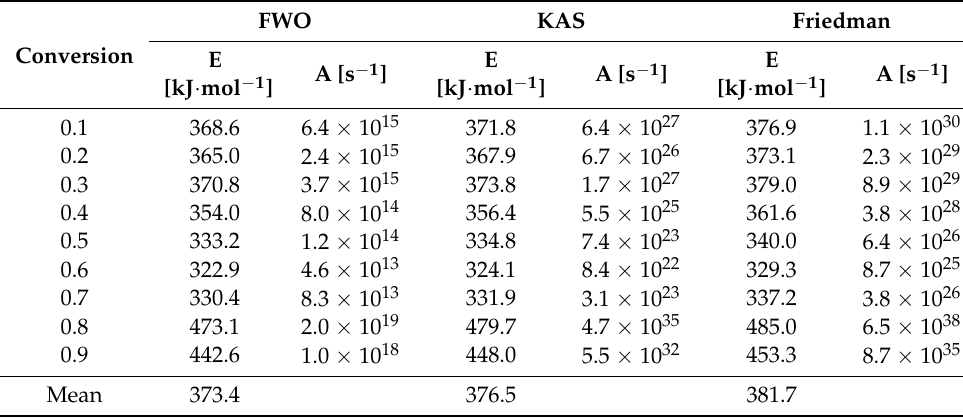
Table 10. Kinetic parameters of TTDA at heating speeds of more than 20 min − 1